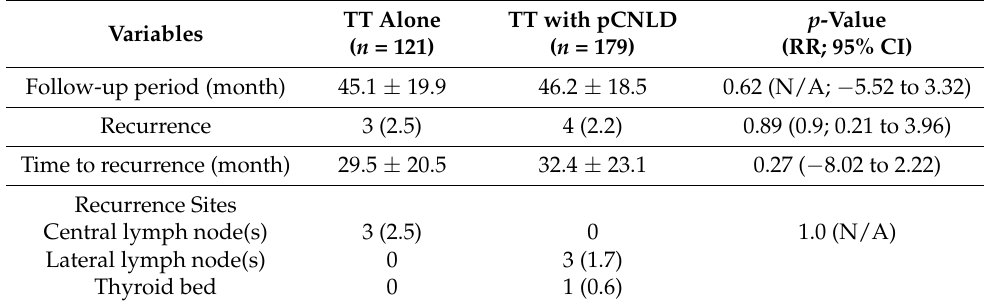
Table 4. Recurrence in the study samples grouped by the primary predictor